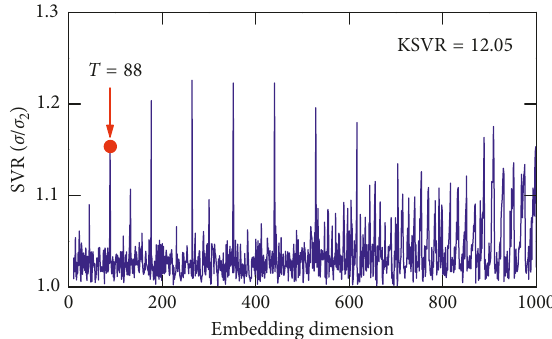
Figure 6: SVR spectrum of the first